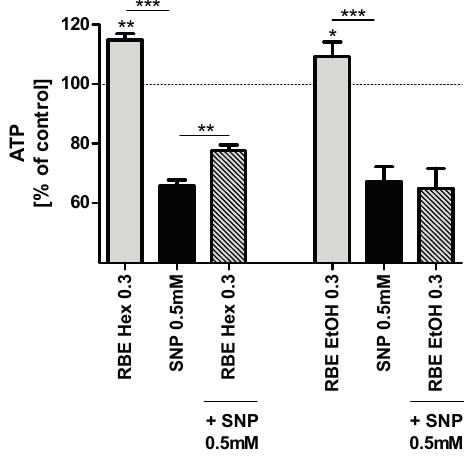
Figure 1. Mitochondrial membrane potential (MMP; gray bars) of PC12 cells after 24-h incubation with 0.3 mg/mL hexanic (RBE Hex) or ethanolic (RBE EtOH) rice bran extract (RBE); MMP after insult with sodium nitroprusside (SNP, 0.5 mM) for 24 h (black bars) and MMP after preincubation of PC12 cells with ethanolic or hexanic RBE for 1 h and insult with SNP (0.5 mM) for 24 h (striped bars); cells treated with cell culture medium served as control for normalization (100%); there were no differences in MMP between medium treated and DMSO or ethanol treated cells (data not shown); n = 5–6; mean ± SEM; ANOVA with Tukey’s post -test; * p < 0.05; ** p < 0.01; *** p < 0.001.